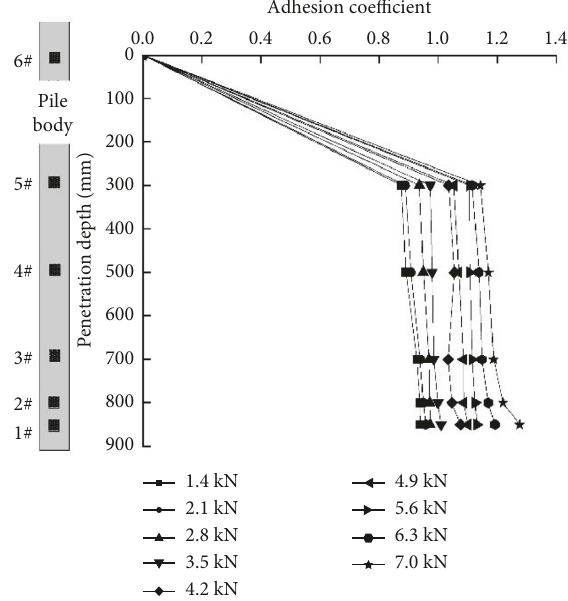
Figure 12: Variation curve of TP2 adhesion coefficient with depth under various